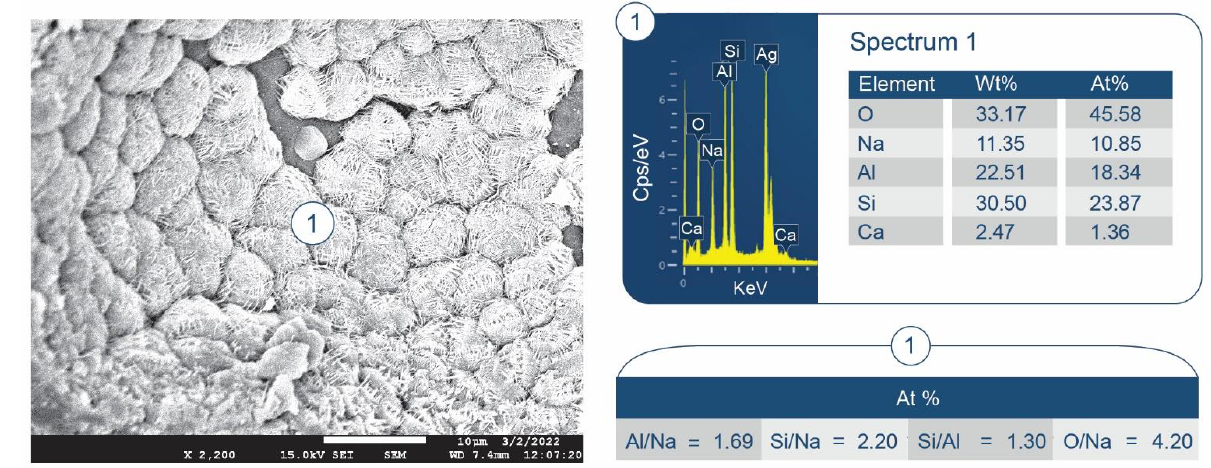
Figure 12. Morphology and elemental composition of pozzolanic reaction products on the surface of FCS of CaP/FCS cement cured at 250 °C.